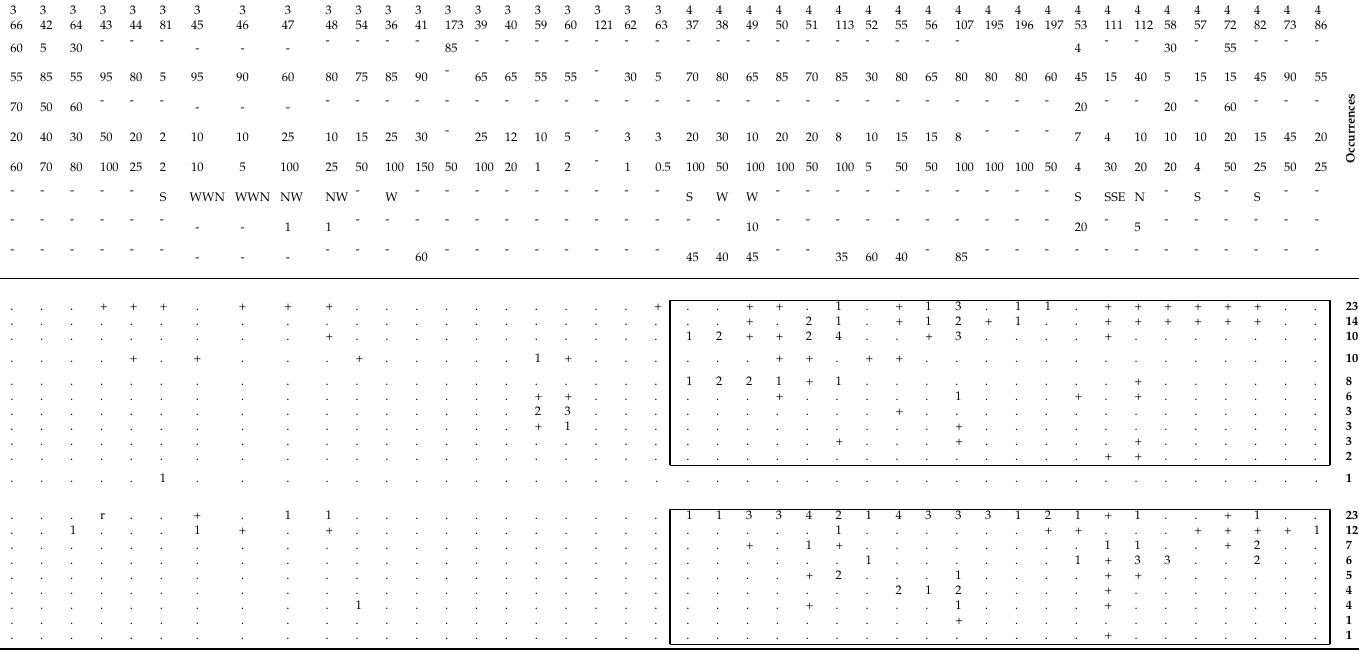
Table A3. Phytosociological relev é s from the Island of Capo Passero (SE Sicily)—dry grasslands. Cluster 47 - - - - - - - 85 60 5 30 - - - - - - - - - - 85 - - - - - - - - - - - - - - - - - 4 - - 30 - 55 - - - Herbaceouslayer(cover%) Shrublayer—meanheight(cm) - - - - - - - - - - - - - - - - - - - - - - - - - - - - - - - - - - - - - 20 - - 20 - 60 - - - Herbaceouslayer—meanheight(cm) Plotsize(squarem) Exposure - - - - - SSW S - - - - - - S WWN WWN NW NW - W - - - - - - - - - S W W - - - - - - - - - - S SSE N - S - S - - Slope( ◦ ) - - - - - 15 - - - - - - - - - - 1 1 - -